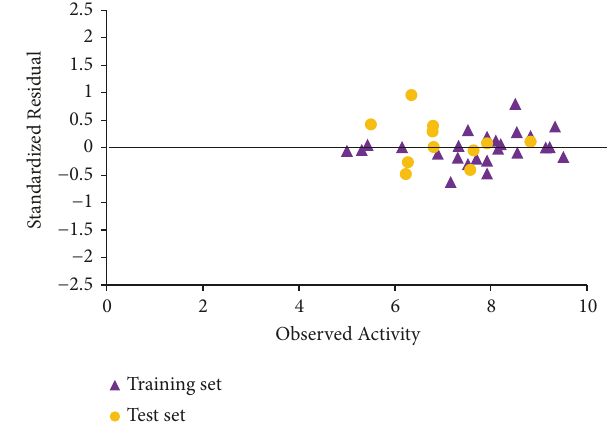
Figure 3: Plot of standardized residual activity versus observed activity.